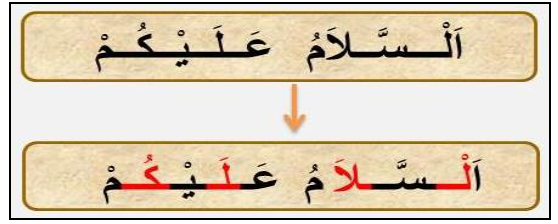
Figure 1. An Arabic greeting